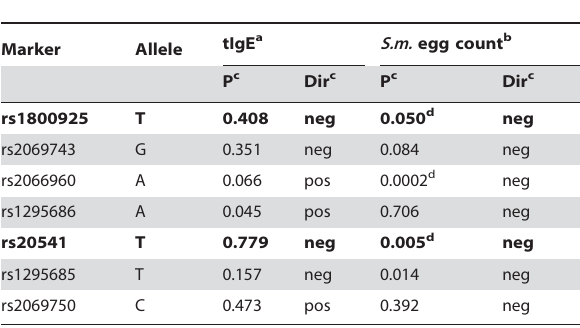
Table 2. Generalized Estimating Equation association tests for individual SNPs with tIgE levels (N= 572) and Schistosoma mansoni egg counts (N=397) under the additive model.